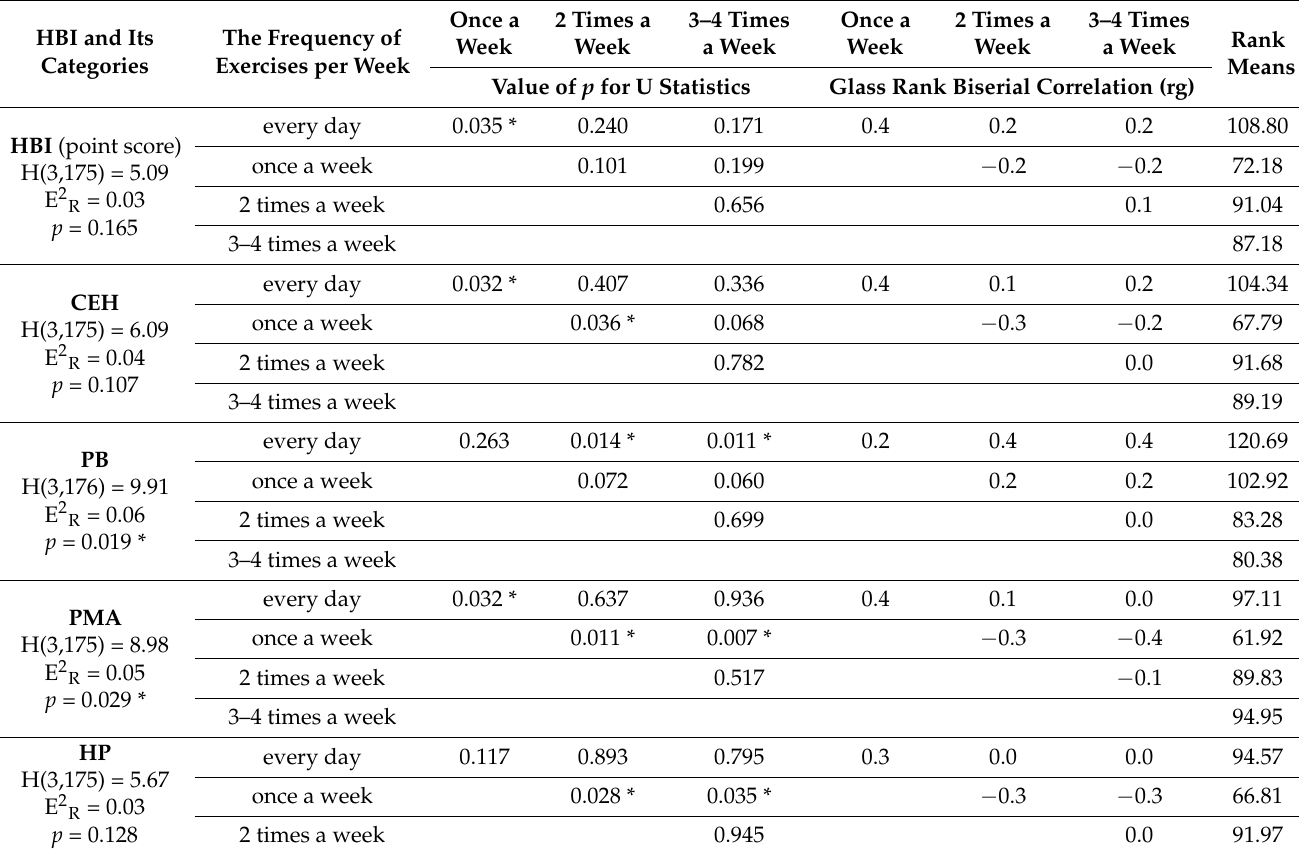
Table 4. Health behaviors of people practicing wheelchair basketball, wheelchair rugby and para- rowing depending on the frequency of exercise per week (the H test, E 2 R , the U test,